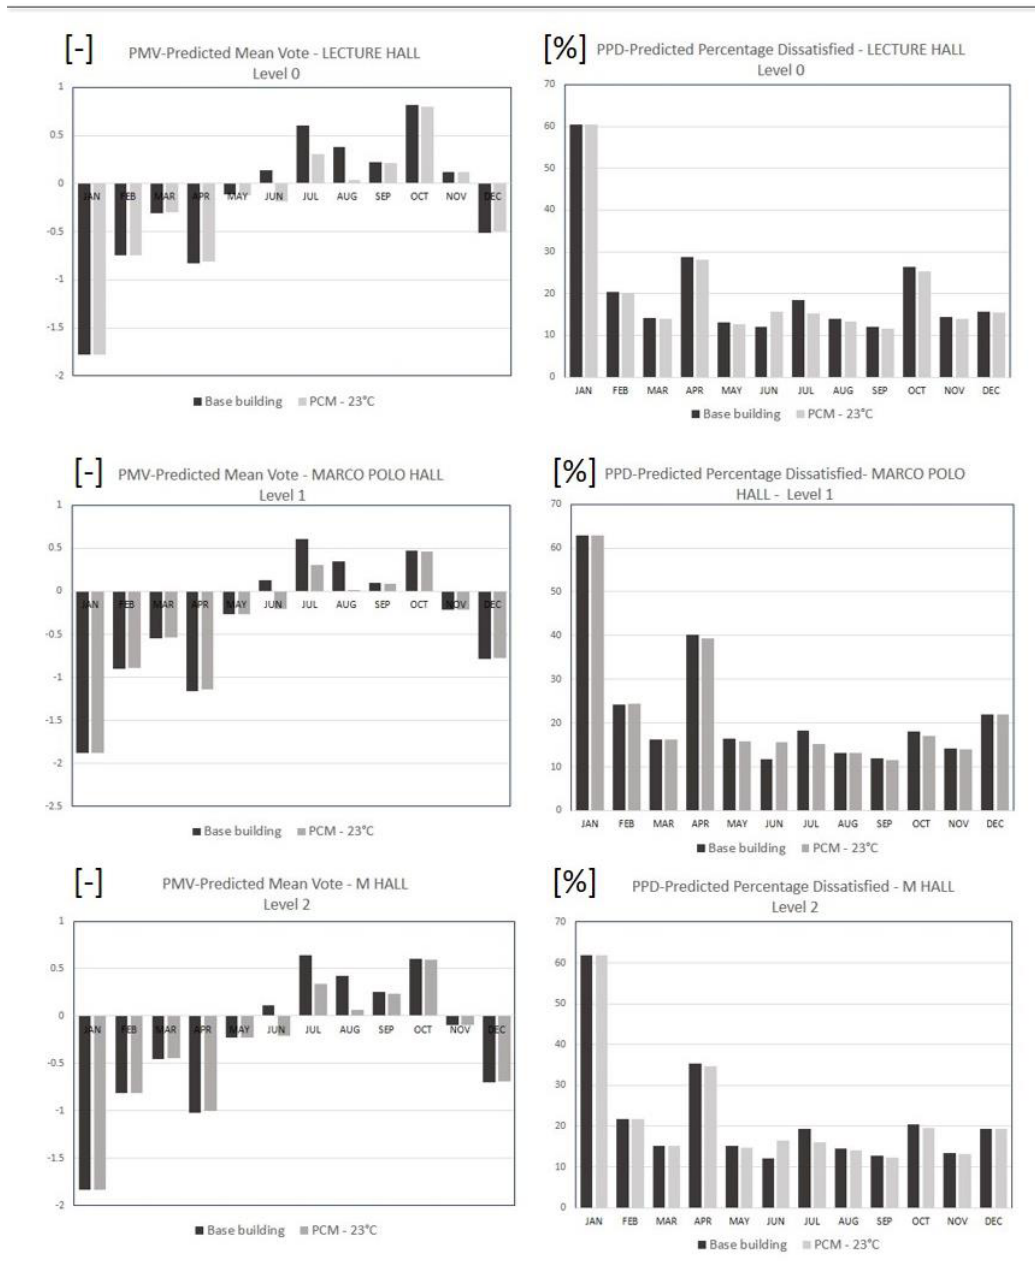
Figure 15. PMV and PPD average month values for three typical rooms during the year.